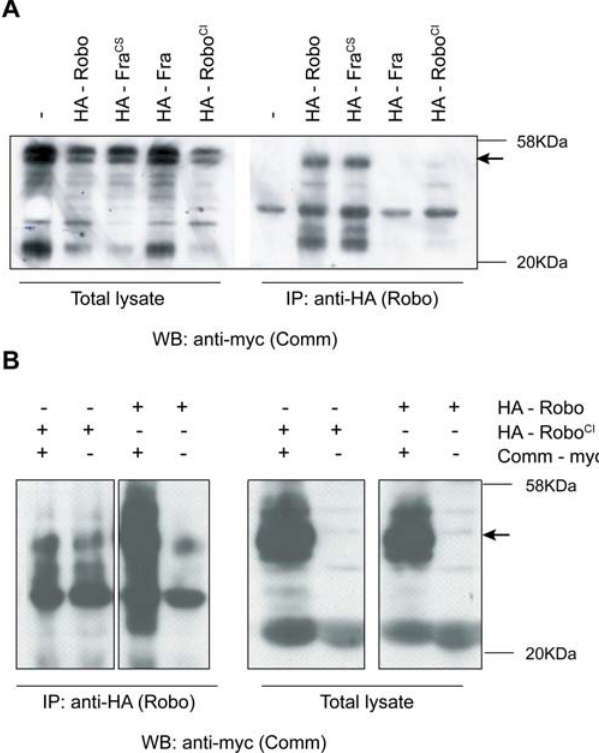
Figure 2. Biochemical interaction between Robo SD and Comm in vitro and in vivo. (A,B) Coimmunoprecipitation of Comm with Robo and Fra CS but not Fra and Robo SD from transfected COS cells (A) and from Drosophila embryos (B). In (B) embryos panneuronally expressing a Myc-tagged version of Comm and a HA-tagged version of either Robo or Robo SD were lysed and immunoprecipitated with anti- HA antibodies. The co-immunoprecipitation was assessed by western blot using anti-Myc antibodies. Equal amounts of expression were controlled by western blot on a smaller fraction of lysate. In both panels molecular weight markers are indicated on the right, in kDa.